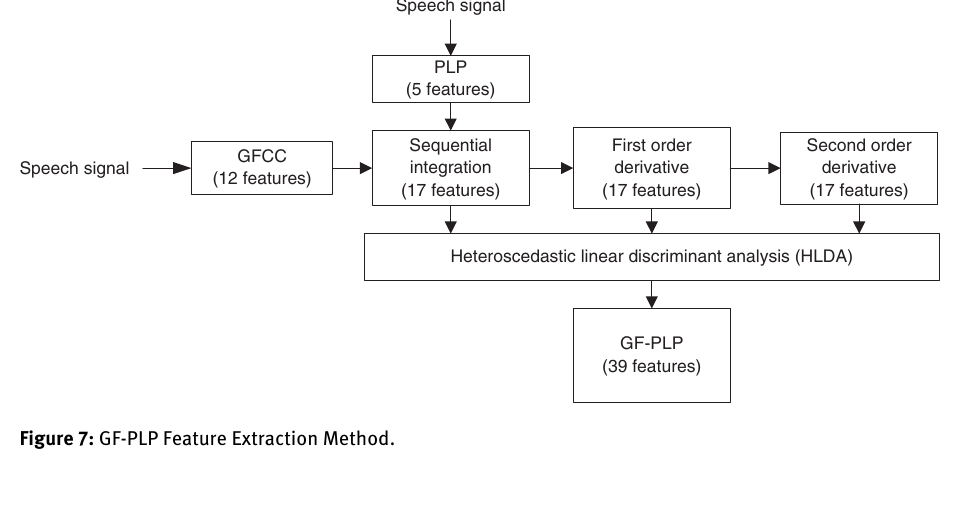
Figure 7: GF-PLP Feature Extraction Method.